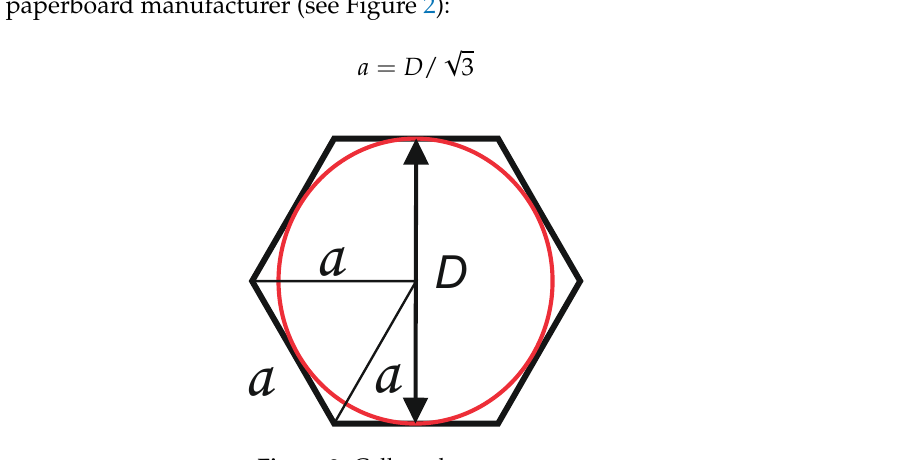
Figure 2. Cell mesh parameters.